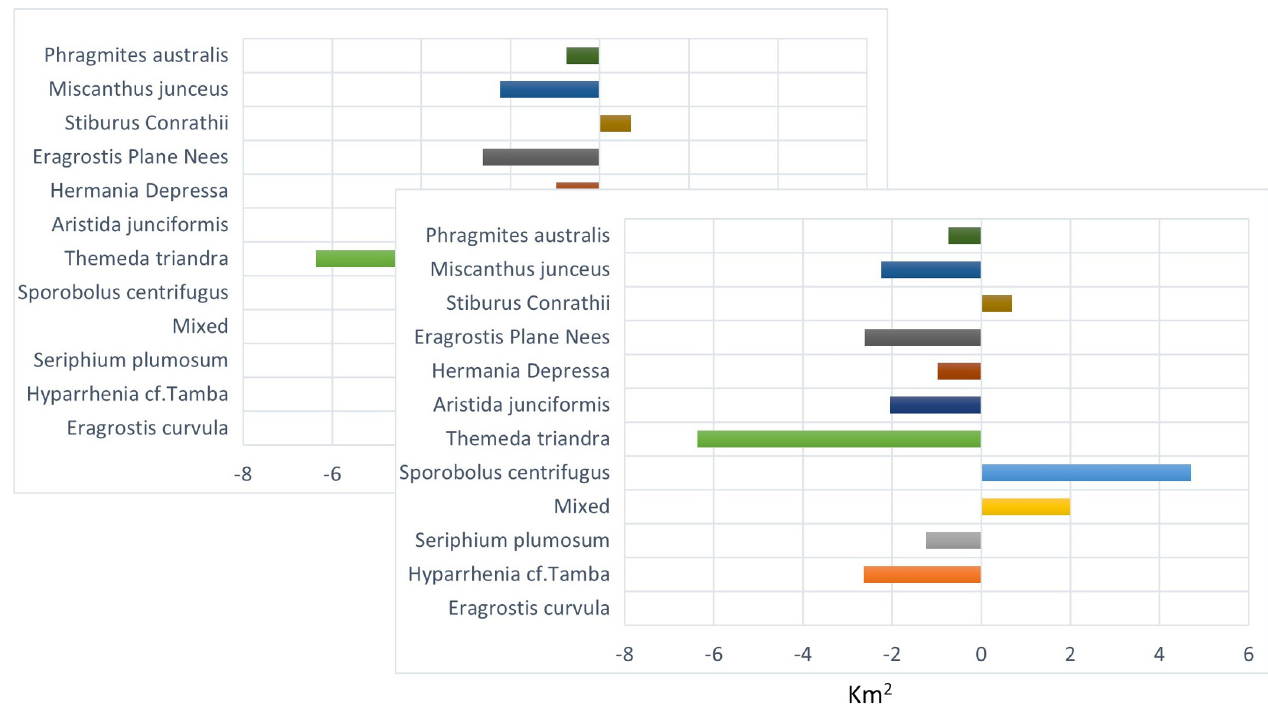
Fig 5. Species contributions to changes in Eragrostis curvula